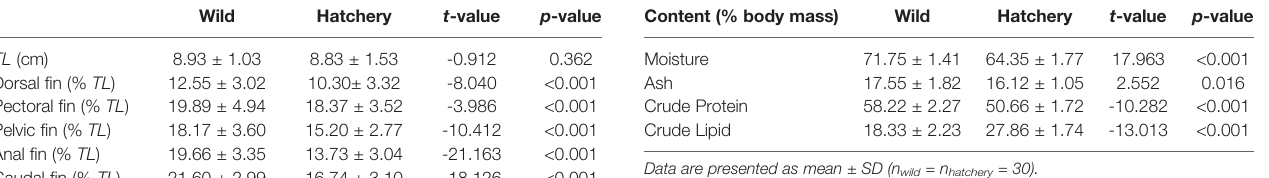
TABLE 1 | Comparison of relative fi n length between wild and hatchery-reared marbled rock fi sh (mean ± SD) ( n wild = 244; n hatchery = 276). Wild Hatchery t -value p -value